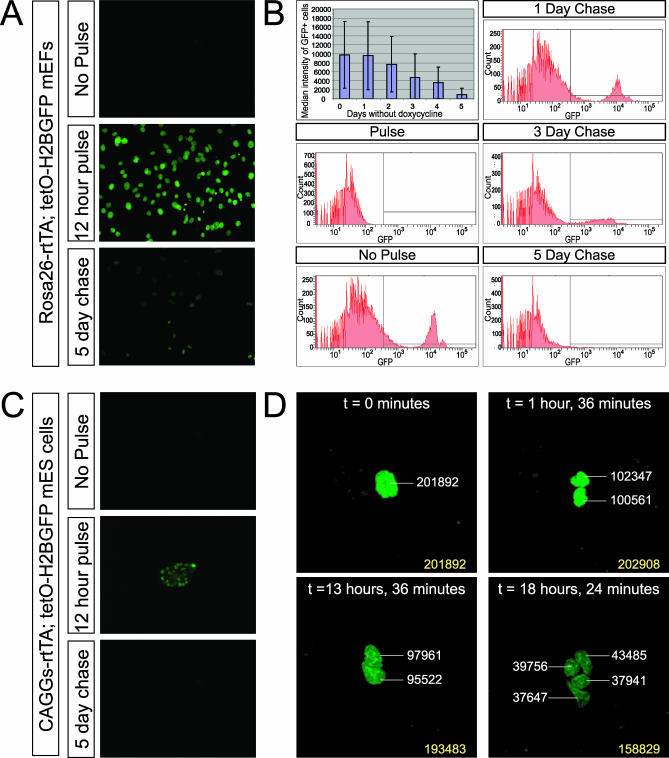
In Vitro Characterization of Dilution of Tetracycline-Inducible H2BGFP with Cell Division(A) Fluorescent images of Rosa26-rtTA; tetO-H2BGFP mEFs pulsed with doxycycline and cultured in the absence of doxycycline. Original magnification, 100×.(B) FACS plots of Rosa26-rtTA; tetO-H2BGFP mEFs pulsed with doxycycline and cultured in the absence of doxycycline. Median intensity of GFP-positive cells versus days cultured without doxycycline shown in graph.(C) Fluorescent images of CAGGs-rtTA; tetO-H2BGFP mES cells pulsed with doxycycline and cultured in the absence of doxycycline. Original magnification, 100×.(D) Time-lapse confocal images of a single CAGGs-rtTA; tetO-H2BGFP mES cell undergoing two rounds of cell division. Integrated pixel intensity shown in white text; total integrated pixel intensity of all cells shown in yellow text. Original magnification, 400×.